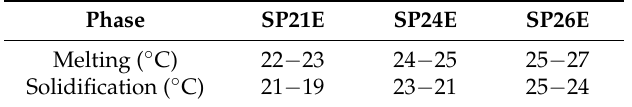
Figure 9. Delivered energy on an annual basis for the three PCM tested in the three cities compared to the STD and NZEB reference buildings. Table 7. Melting and solidification temperature ranges for the three PCM tested.